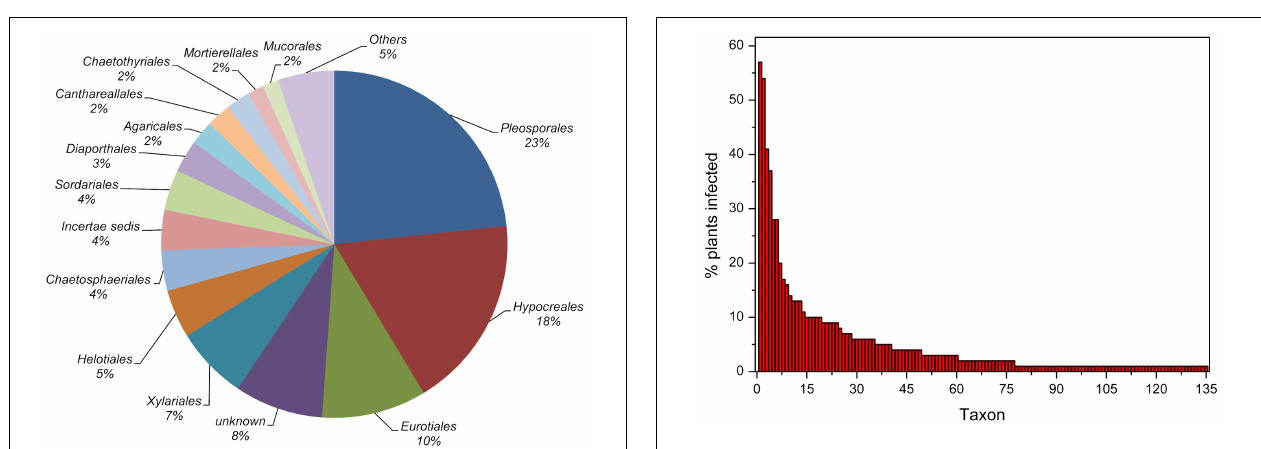
FIGURE 1 | Distribution of fungal taxa from roots of Festuca rubra subsp. pruinosa plants from marine cliffs in northern Spain according to orders.